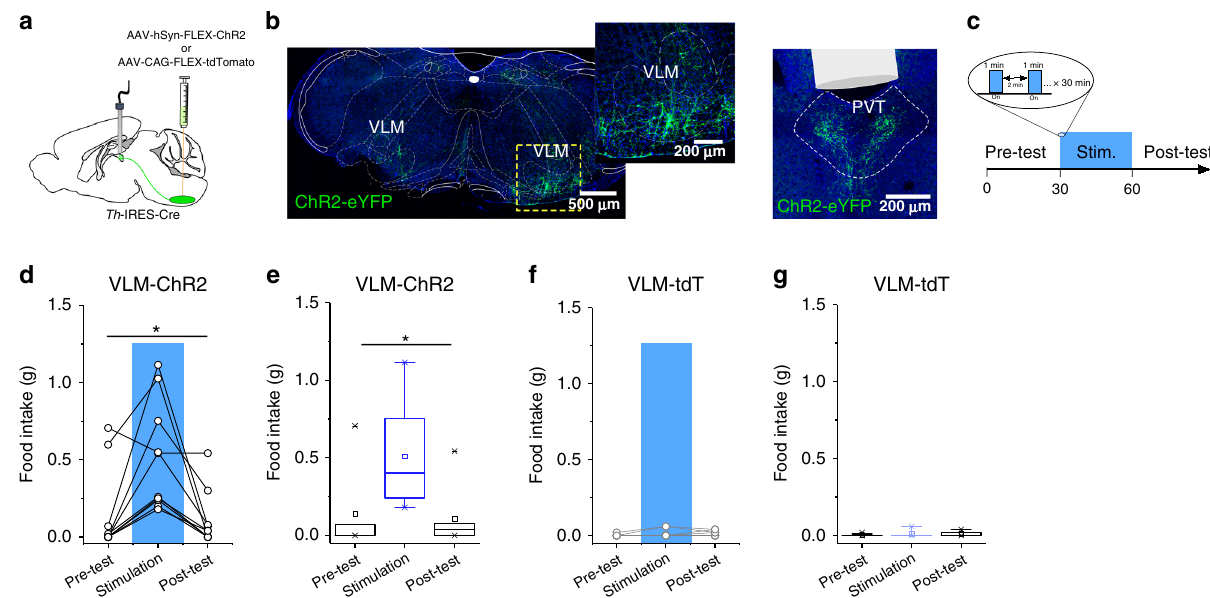
Fig. 2 Optogenetic stimulation of the VLM CA terminals in the pPVT results in robust feeding behavior in well-fed mice. a Schematic of ChR2-expressing and control viral vector injections, as well as optical fi ber implantation for optogenetic activation VLM CA fi bers in the pPVT. b Representative image of ChR2 expression in the VLM of TH-IRES-Cre mice and ChR2-labeled terminals in the pPVT. c Schematic of the experimental design and the stimulation protocol used to measure feeding behavior during optogenetic stimulation of VLM terminals in the pPVT. Food intake was quanti fi ed in well-fed mice prior to, during, and after light stimulation (30 min, pre-test, stimulation, and post-test). The stimulation protocol consisted of 30 min in which light stimulation alternated between 1 min “ light ON ” (20 Hz) and 2 min “ light OFF ” bouts. d Plot of individual performance on feeding behavior during the